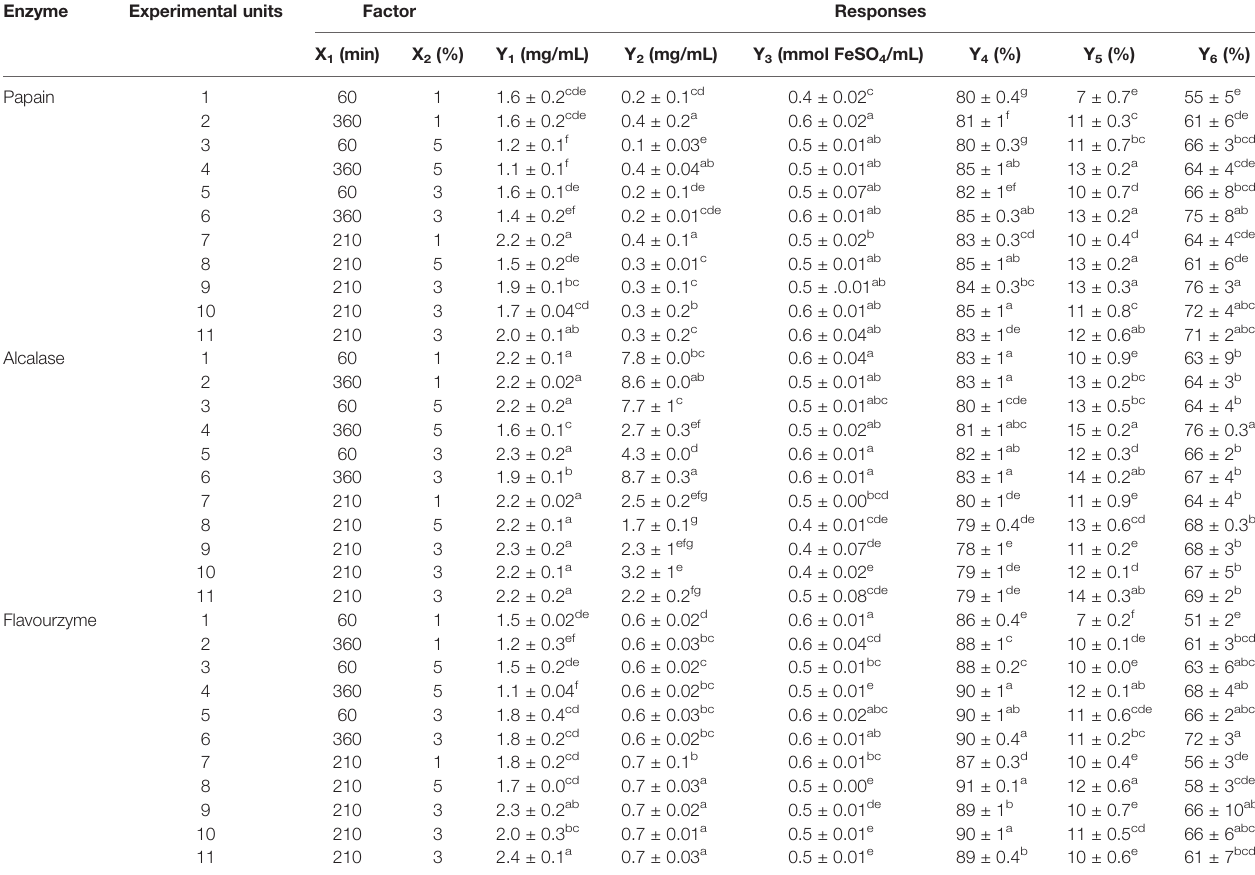
TABLE 1 | The experiment units and responses for sea cucumber hydrolysate using papain, alcalase or fl avourzyme hydrolysis. Enzyme Experimental